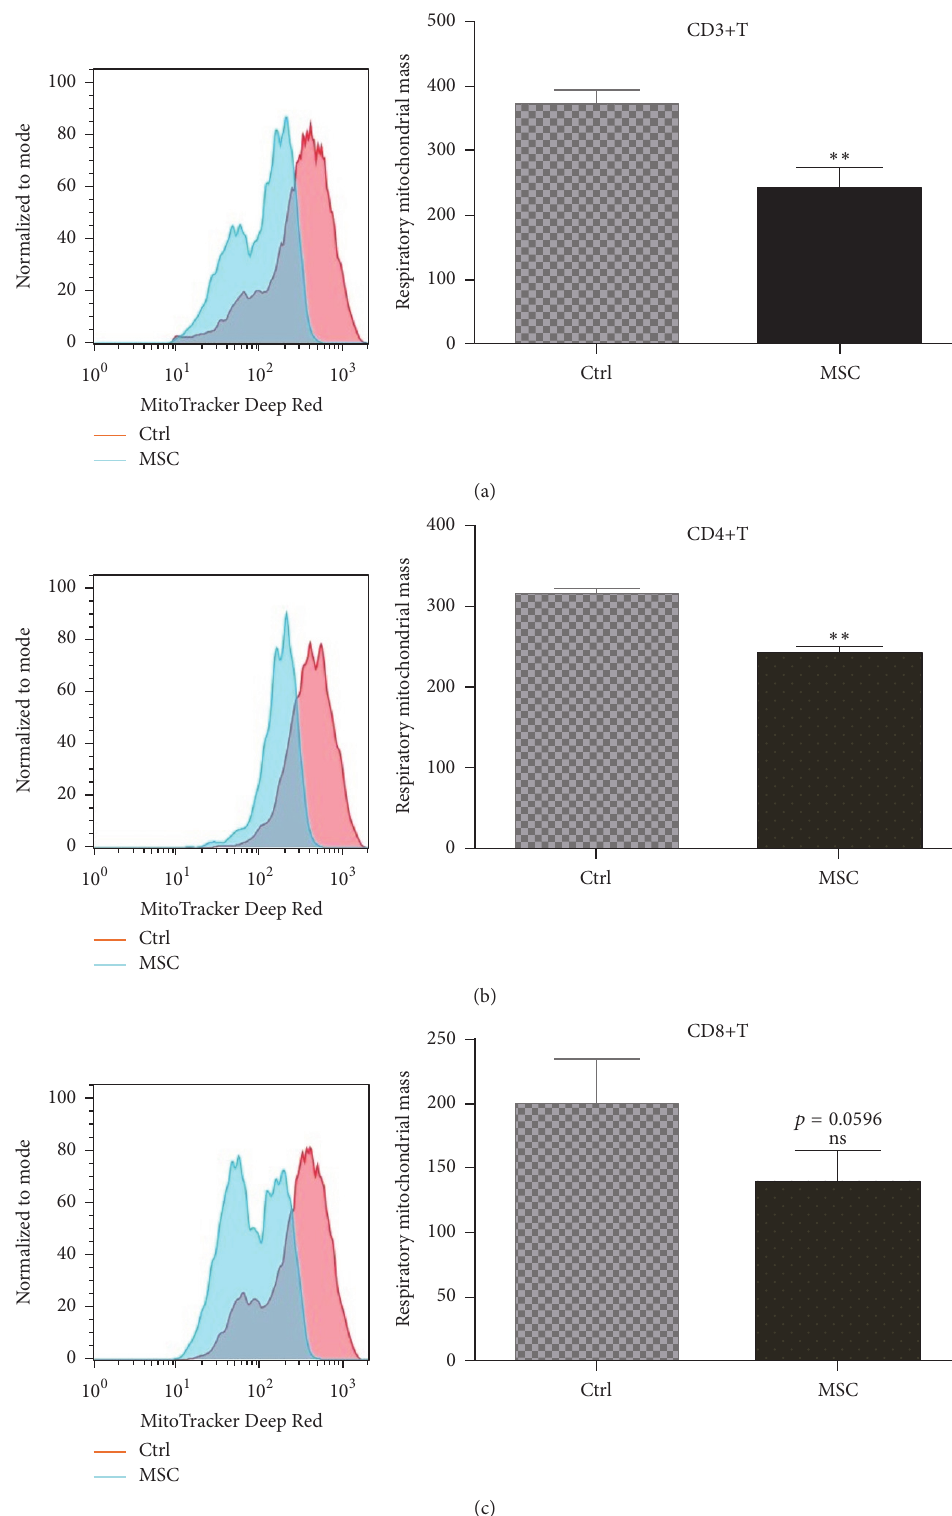
Figure 5: UC-MSCs inhibited respiratory mitochondrial accumulation in T cells from SLE patients. PBMCs from SLE patients were activated with anti-CD3/CD28 antibodies and cultured with or without mesenchymal stem cells (UC-MSCs) for 72 h. All experiments were performed in triplicate. (a–c) UC-MSCs inhibited respiratory mitochondrial accumulation in activated CD3+T, CD4+T, and CD8+T cells ( 𝑛 = 4 ). ns, not significant; ∗∗ 𝑝 < 0.01